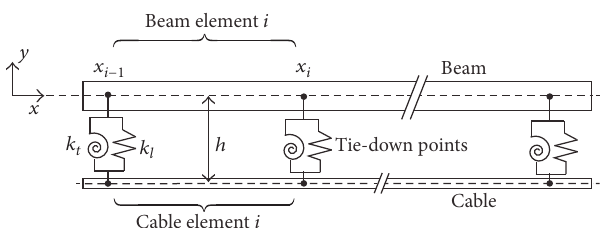
Figure 2: Double-beam model for a cabled